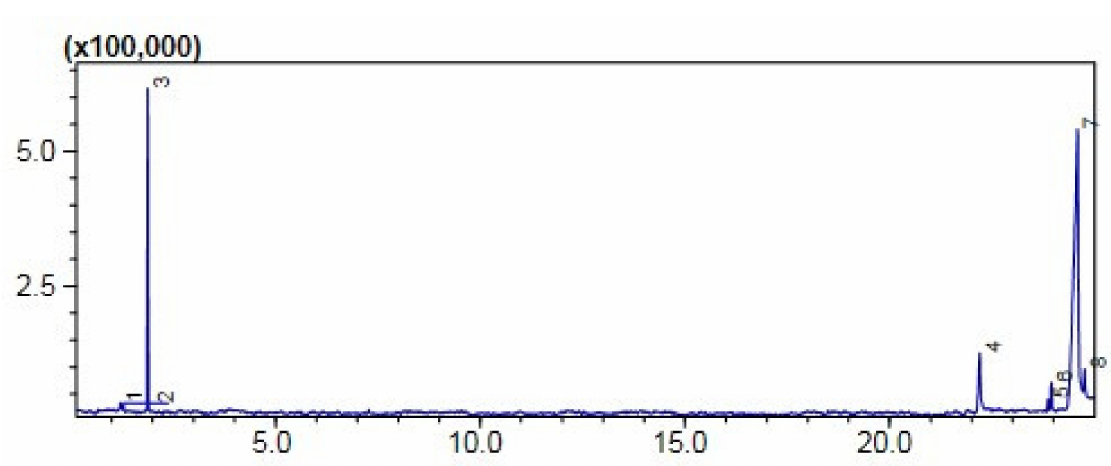
Figure 13. GC Chromatogram of PAOB treated with KPC.